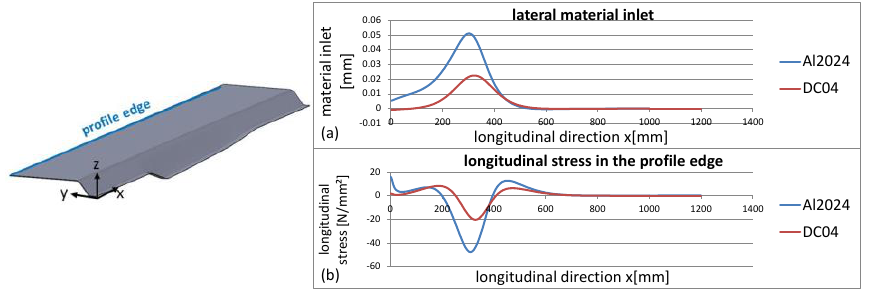
Figure 25. Material inlet ( a ) and longitudinal stress in the profile edge ( b ) of the DC04 and Al2024 blanks.